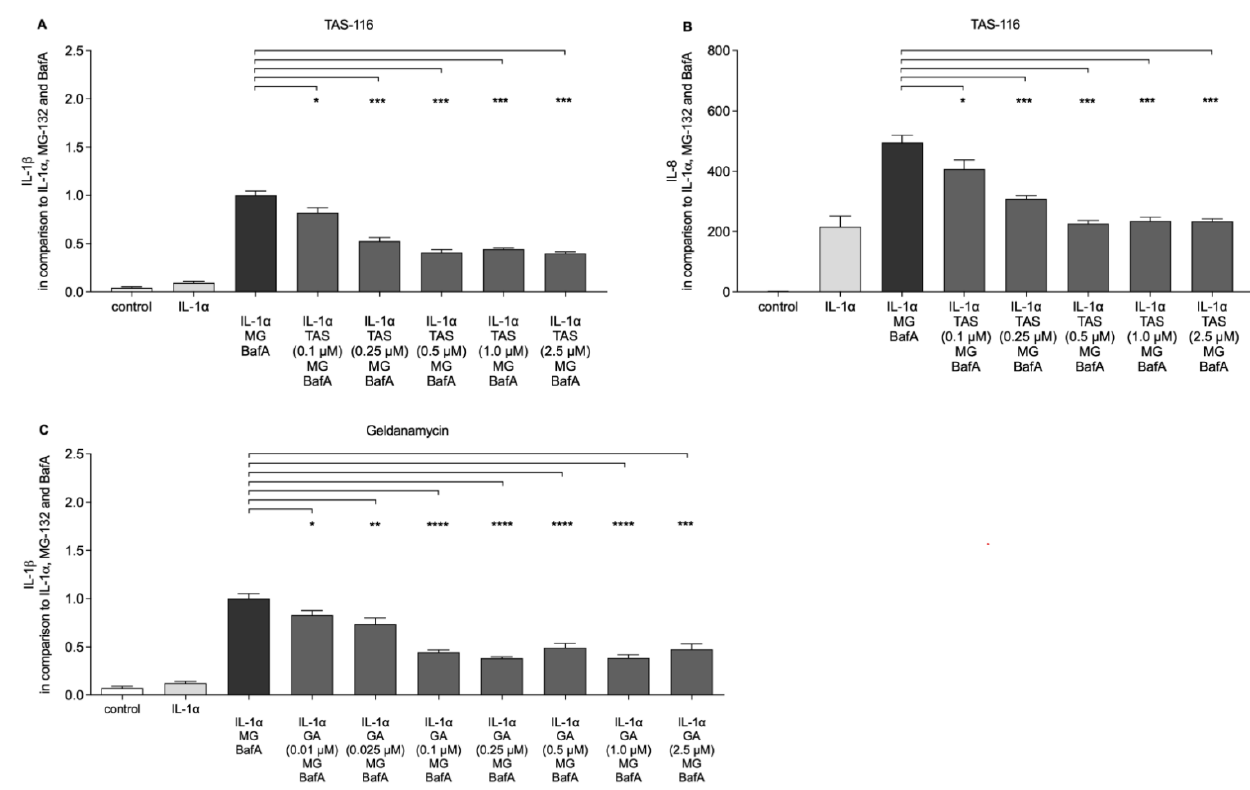
Figure 2. The effect of TAS-116 (TAS) on the release of IL-1 β ( A ) and IL-8 ( B ), and the effect of geldanamycin (GA) on the release of IL-1 β ( C ). IL-1 α -primed RPE cells were exposed concurrently to TAS or GA and MG-132 (MG), and 24 h later to Bafilomycin A1 (BafA). IL-1 β release from TAS- or GA-treated cells was measured from cell culture medium samples and compared to the values in the IL-1 α + MG + BafA group, which was set to a value of 1. Data are combined from two to three independent experiments with four parallel samples in each group and are presented as mean ± SEM. * p < 0.05, ** p < 0.01, *** p < 0.001 **** p < 0.0001, Mann–Whitney U test.